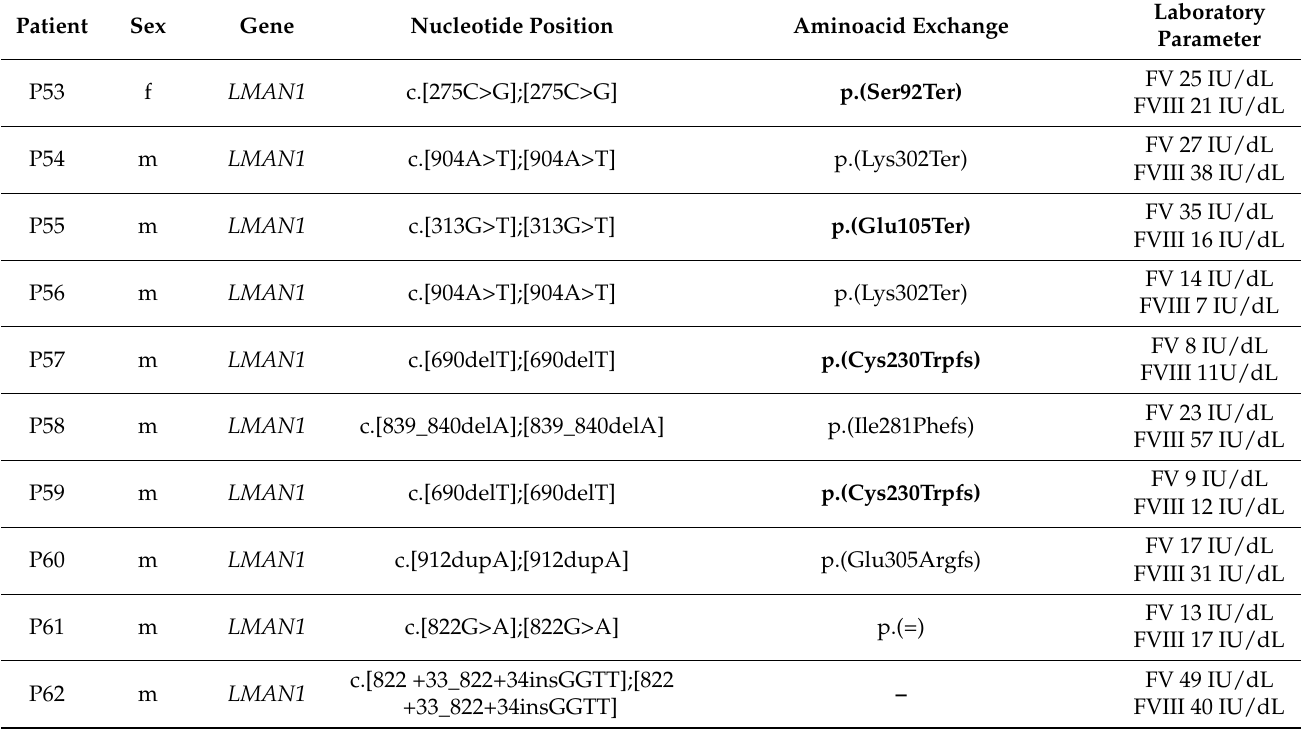
Table 2. Laboratory and genetic features of the FMCFDs arising from single genetic defects—combined deficiency of FV and FVIII and combined VKDCF deficiency (m = male, f = female); VKDCF—vitamin K–dependent clotting factors, p . = synonymous variant, NA = not available due to vitamin k prophylaxis, IU/dL = international